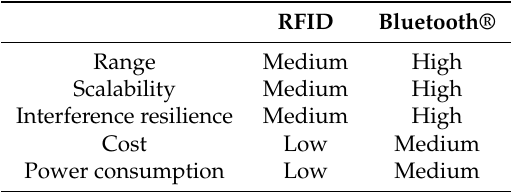
Table 3. RFID and Bluetooth® comparison